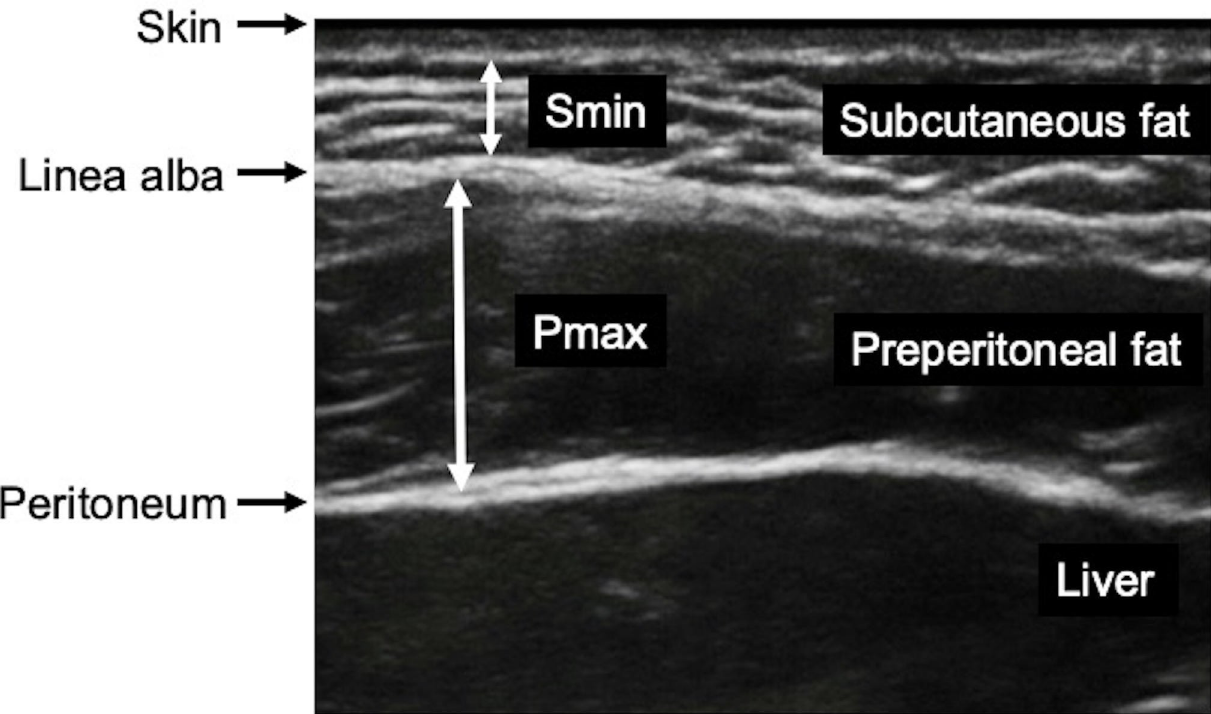
Fig 2. Ultrasound image of the upper abdominal wall on the xiphoumbilical line. Electronic calipers were used to measure the maximum preperitoneal fat thickness (Pmax) and minimum subcutaneous fat thickness (Smin).